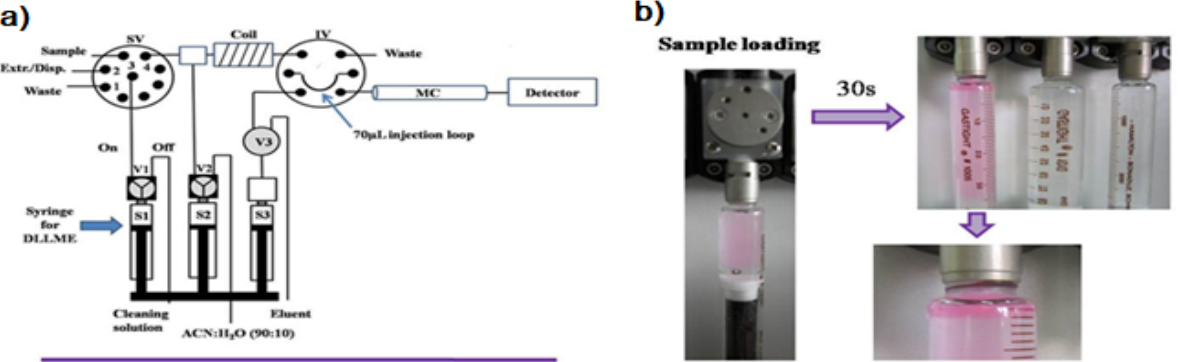
Figure 1. ( a ) Developed instrumental set-up for DLLME combined multisyringe chromatography (MSC) [13]: S1–S3, syringes. V1–V3, solenoid valves. SV, 8-port selection valve. Extr./Disp.,